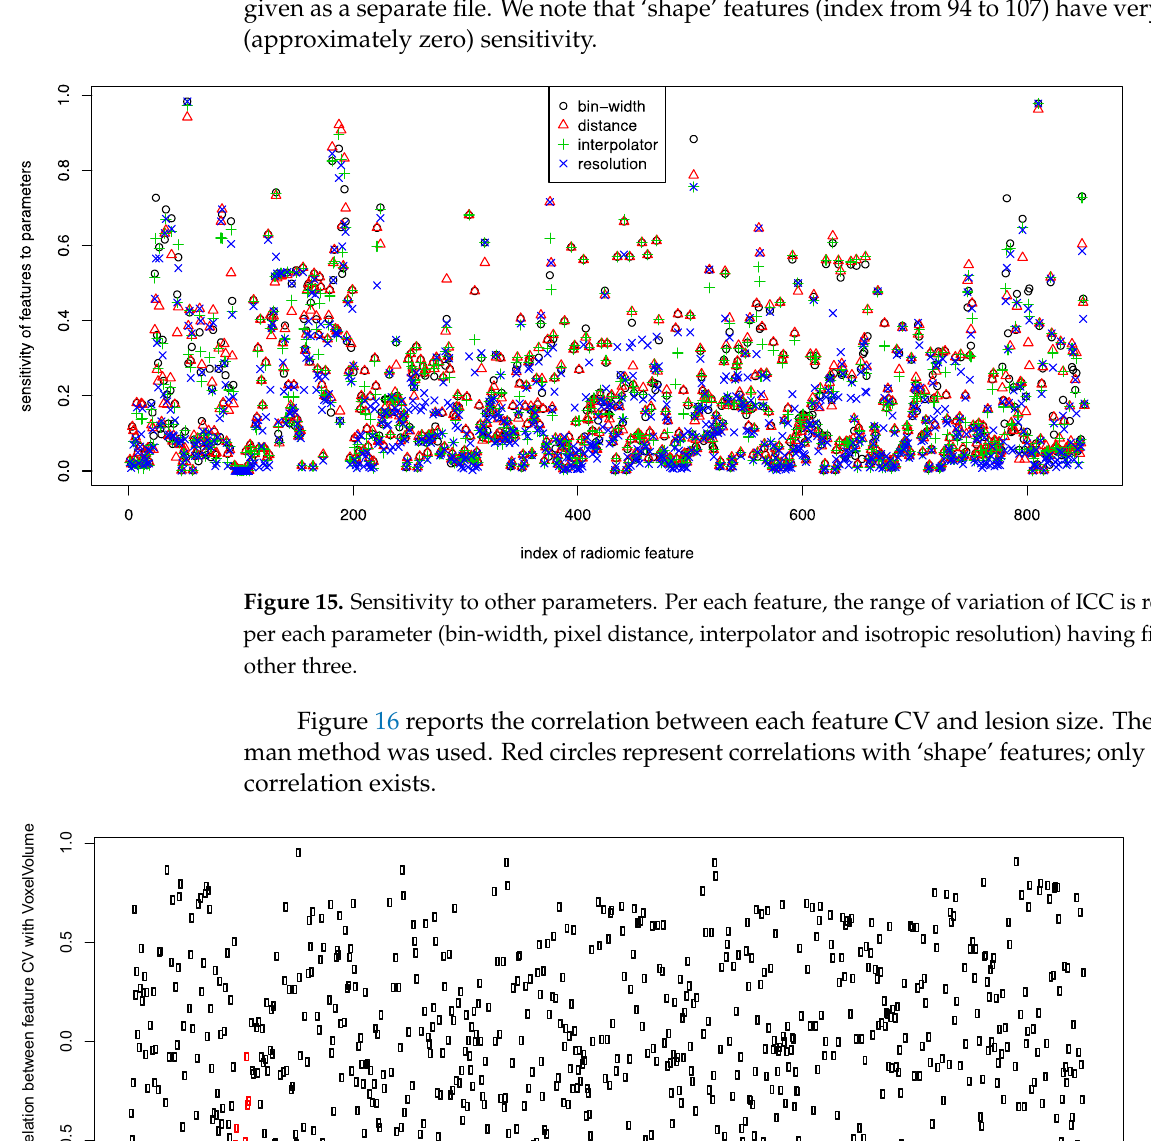
Figure 14. Robustness of wavelet-based second-order NGTDM features across segmentations. The vertical dashed red line indicates the ICC > 0.9 threshold. Pyradiomics provides five such features.